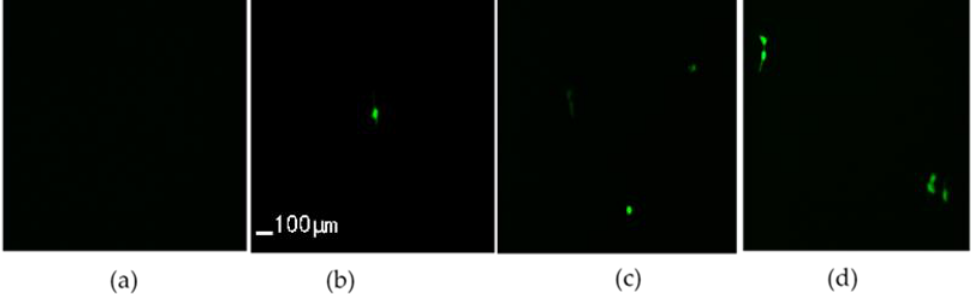
Figure 13. Results of green fluorescent protein expression in HeLa cells ( × 200): ( a ) only plasmids added; ( b ) plasmids added and sonicated with No.2 transducer for 20 s; ( c ) plasmids added and sonicated with No.4 transducer for 20 s; ( d ) plasmids added and sonicated with No.2 and 4 transducers simultaneously for 20 s.